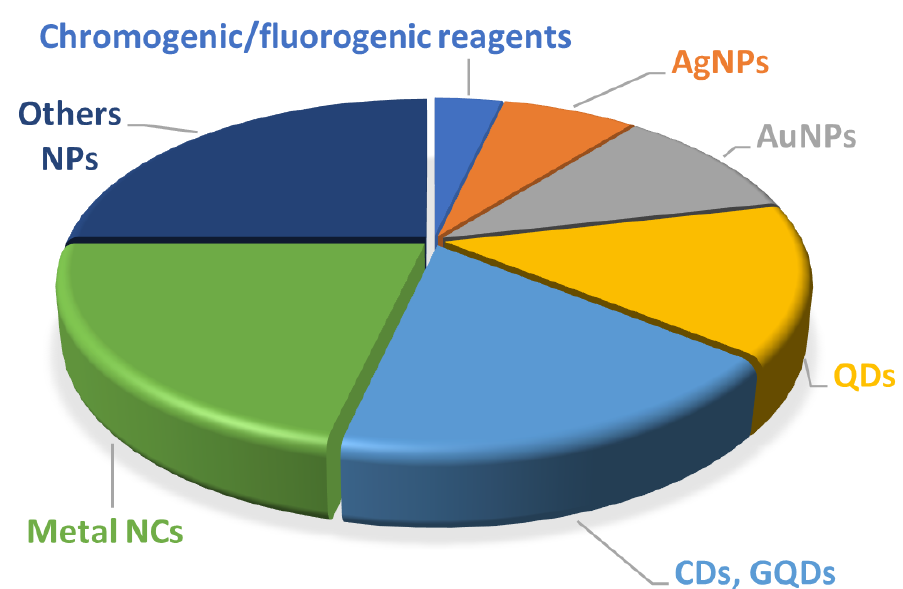
Figure 2. Percentage of publications related to the application of PADs with different recognition elements for sensing Hg(II) in water using colorimetry and luminescence. AgNPs, silver nanoparticles; AuNPs, gold nanoparticles; CDs, carbon dots; GQDs, graphene quantum dots; NCs, nanoclusters; NPs, nanoparticles; QDs, quantum dots